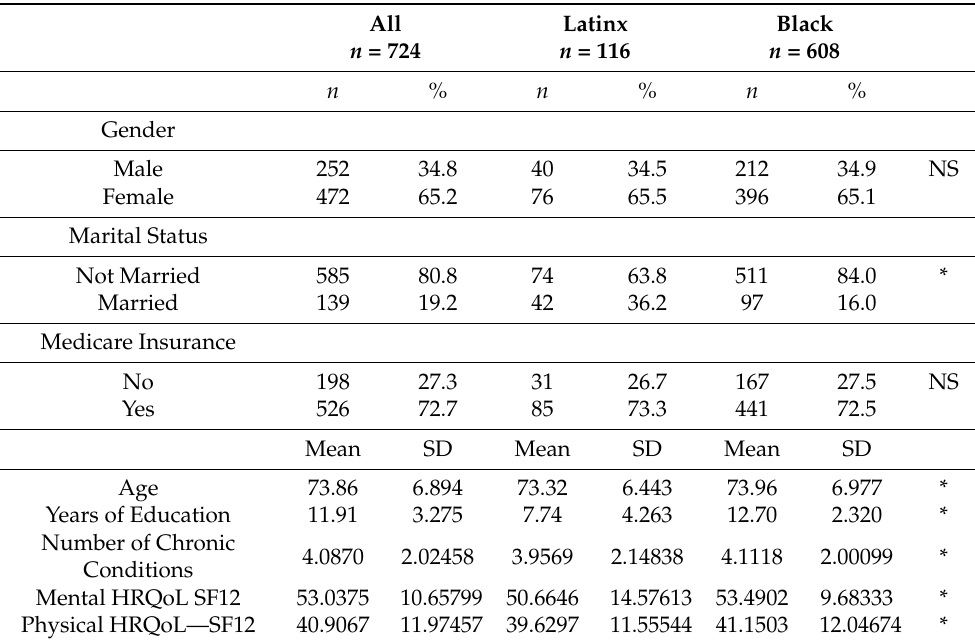
Table 1. Descriptive data overall and by race/ethnicity.